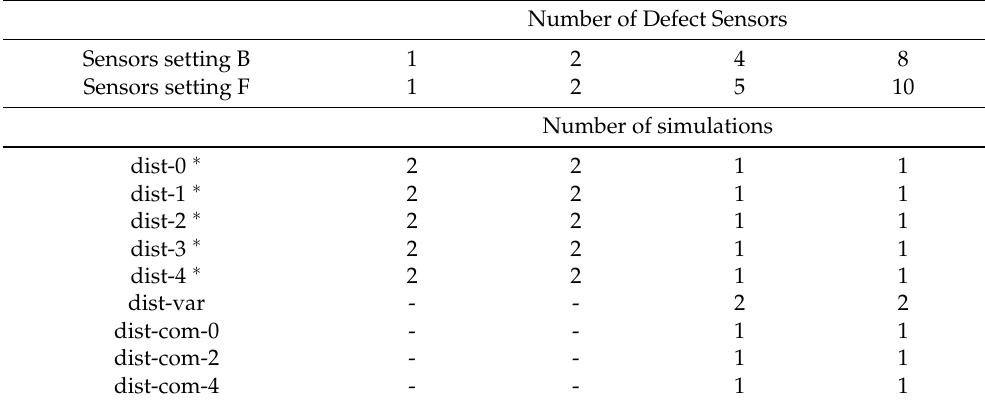
Table 3. Number of defect sensors per platform arrangement and number of simulations calculated for the respective number of defect sensors executed for rope fault detection in rope number 1. The indices ∗ at the distances between the platforms with the defect sensors and the platforms with the rope fault, dist-0 to dist-4, indicates that the defect sensors also occur at adjacent platforms to the given distance at the simulations with 8 and 10 defect